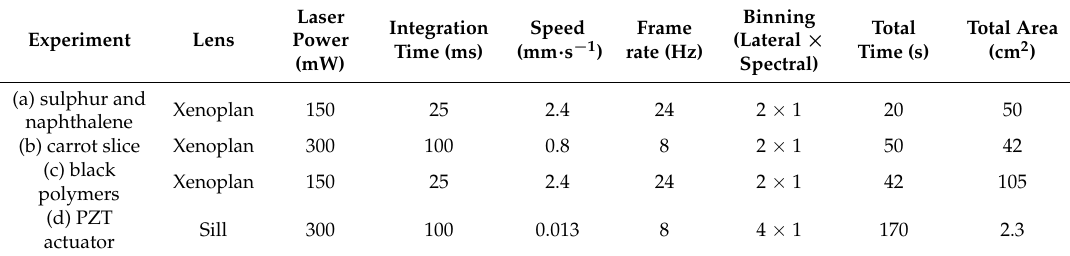
Table 1. Experimental